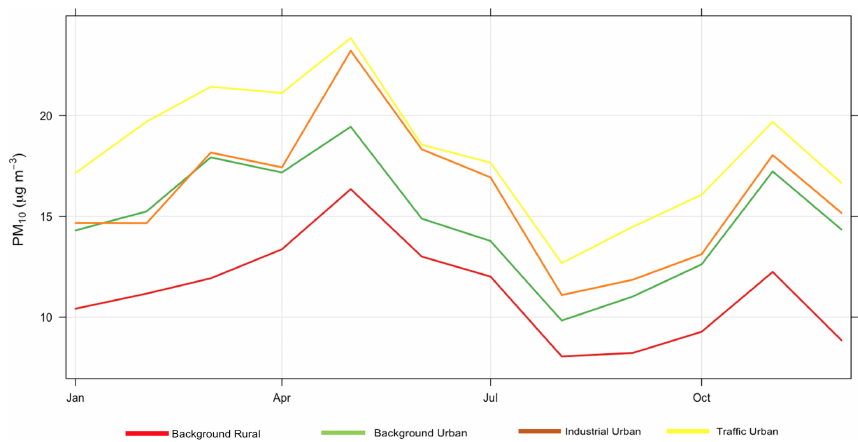
Figure 10. Monthly average concentrations of observed PM 10 for each environmental type for the year 2018.